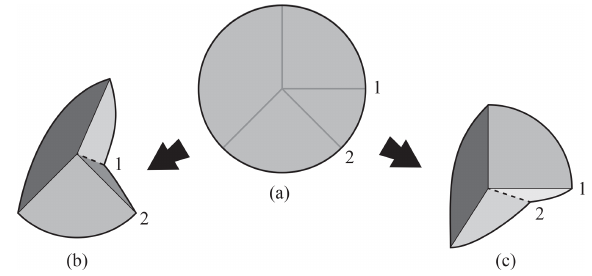
Figure 7. The frequency (as a percentage) of the device fold states when the device is manufactured. These values only represent de- vices with clear manufacturing fold states.